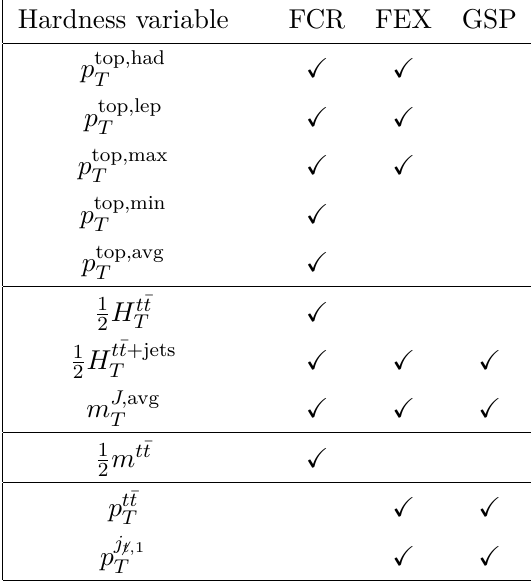
. See text for details and table 1 top